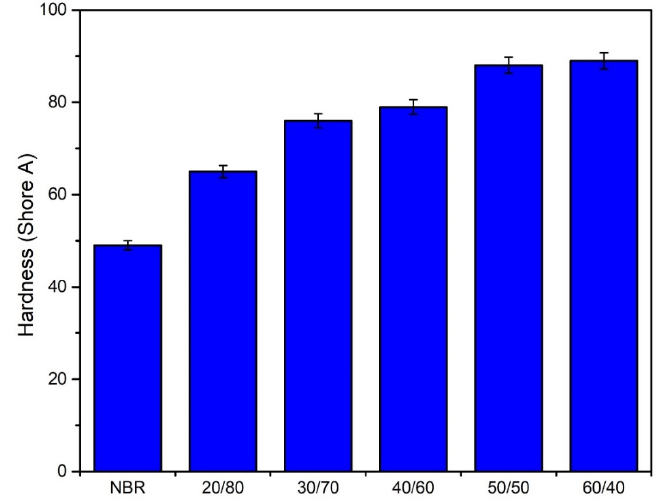
Figure 4. Effect of leather added to NBR on the hardness of composite.